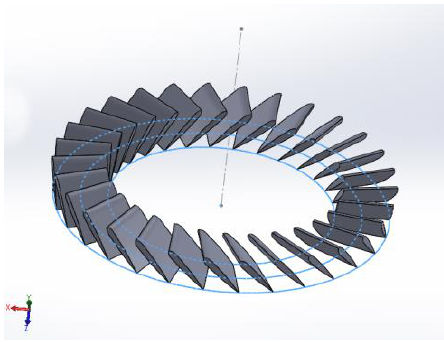
Fig. 12. Stator blade cascade in the annular